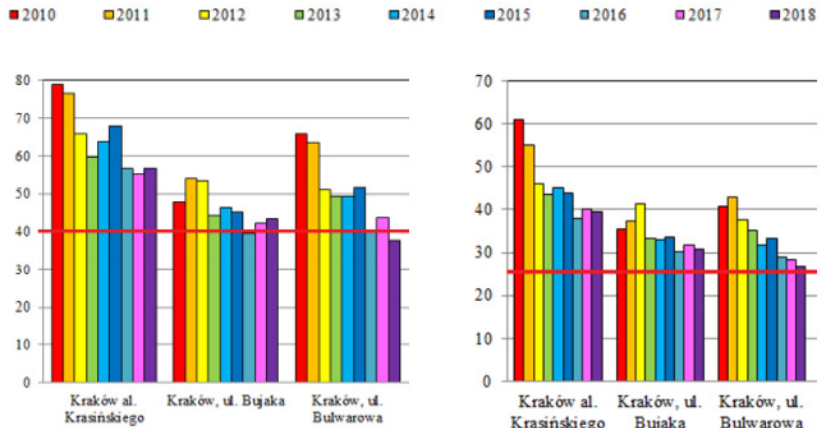
Figure 4. Annual mean concentrations of PM10 ( left ) and PM2.5 ( right ) in Krakow from three measurement points [ µ g/m 3 ] in the years 2010–2018 according to Chief Inspectorate for Environmental Protection in Poland (modified); the norm value (40 µg/m 3 for PM10 and 25 µg/m 3 for PM2.5) is marked with a red line.